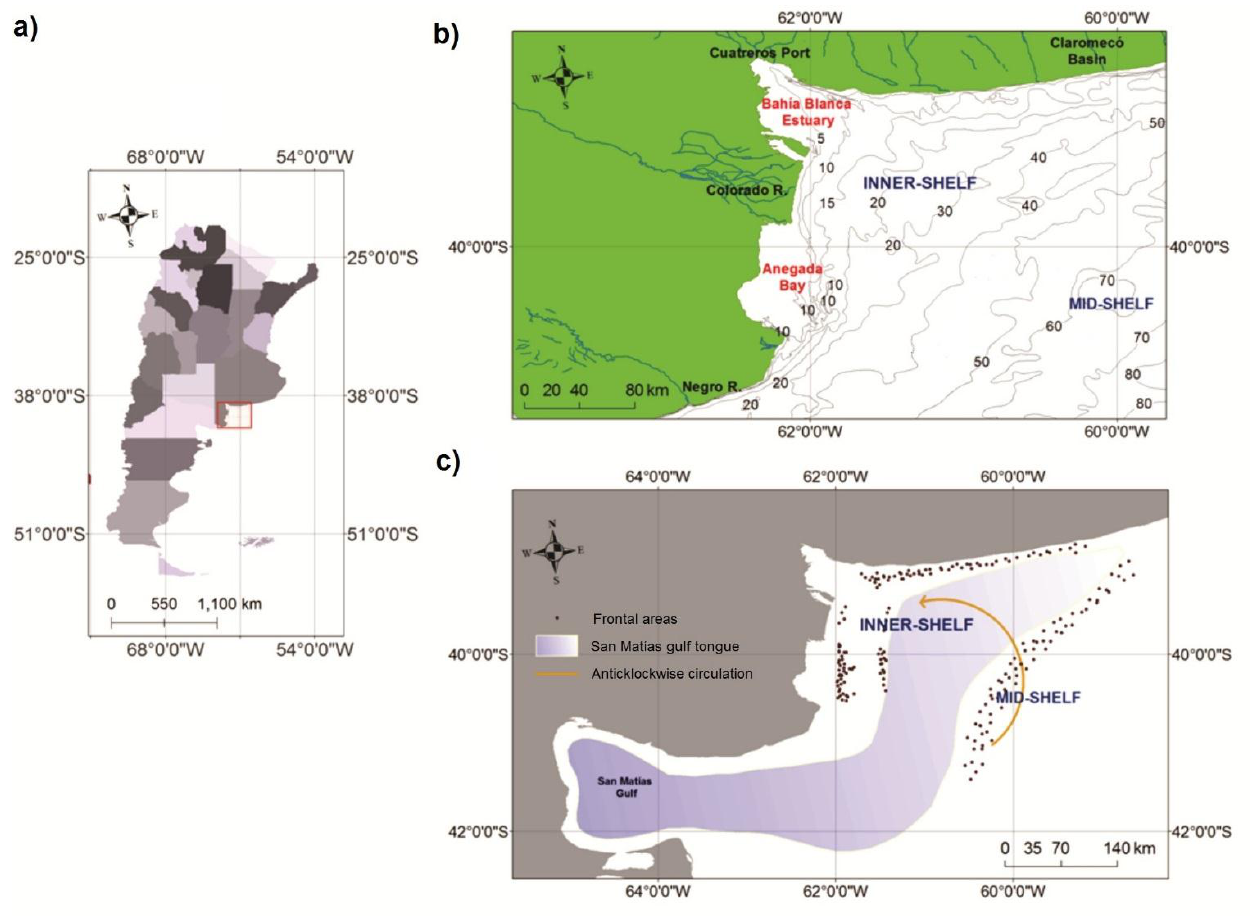
Figure 1. Location of the study area. ( a ) south of Buenos Aires Province, Argentina; ( b ) Bathymetry map of the study area; ( c ) scheme of the main physical oceanographic processes in the study area accordingly